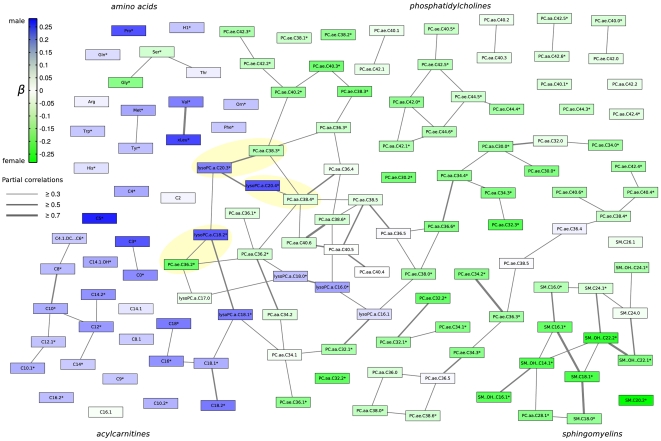
Gaussian graphical model of all measured metabolites illustrating the correlation strength and the propagation of gender-specific effects through the underlying metabolic network.Each node represents one metabolite whereas edge weights correspond to the strength of partial correlation. Only edges with a partial correlation above r =  0.3 are shown. Node colouring represents the strength of association (measured using β from linear regression analysis) towards either males or females. Metabolite names marked with a star * represent significantly different metabolites between genders. Yellow highlighted pairs of metabolites differ by a C18∶0 fatty acid residue.